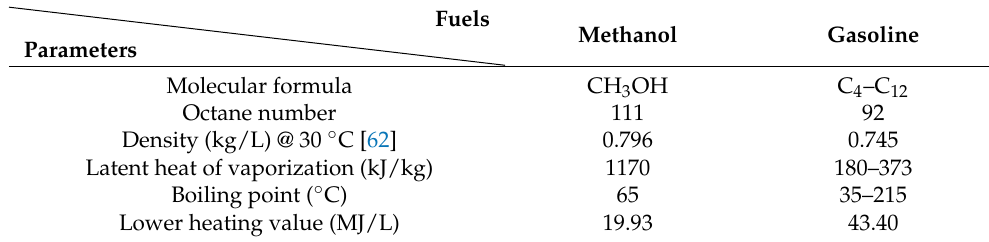
Table 4. Main properties of methanol and